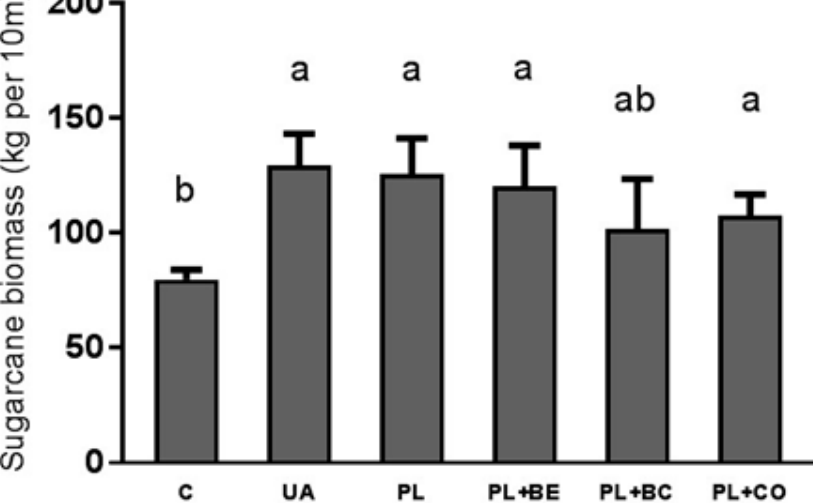
Figure 1. Sugarcane biomass per treatment ( n = 3) recorded on the final day of the field experiment on 23 September 2015. C no-N control, UA urea (mineral fertiliser), PL poultry litter, PL + BE poultry litter + bentonite, PL + BC poultry litter + biochar, PL + CO poultry litter + compost. Statistical analyses: one-way ANOVA plus Fisher’s LSD post-hoc test. Different letters indicate treatment differences at p < 0.05 level.